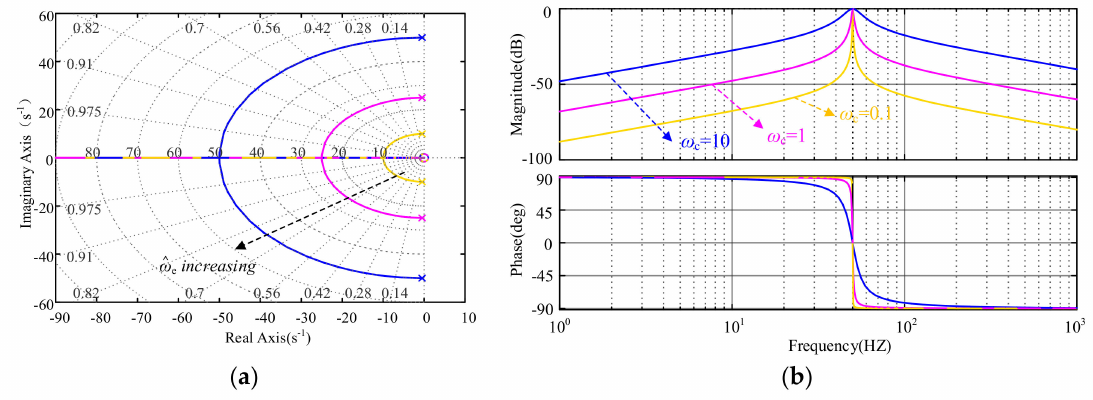
Figure 5. Analysis of the SFT function. ( a ) The root of the SFT function when ω c is increased; ( b ) Bode diagram of the SFT function when ω c